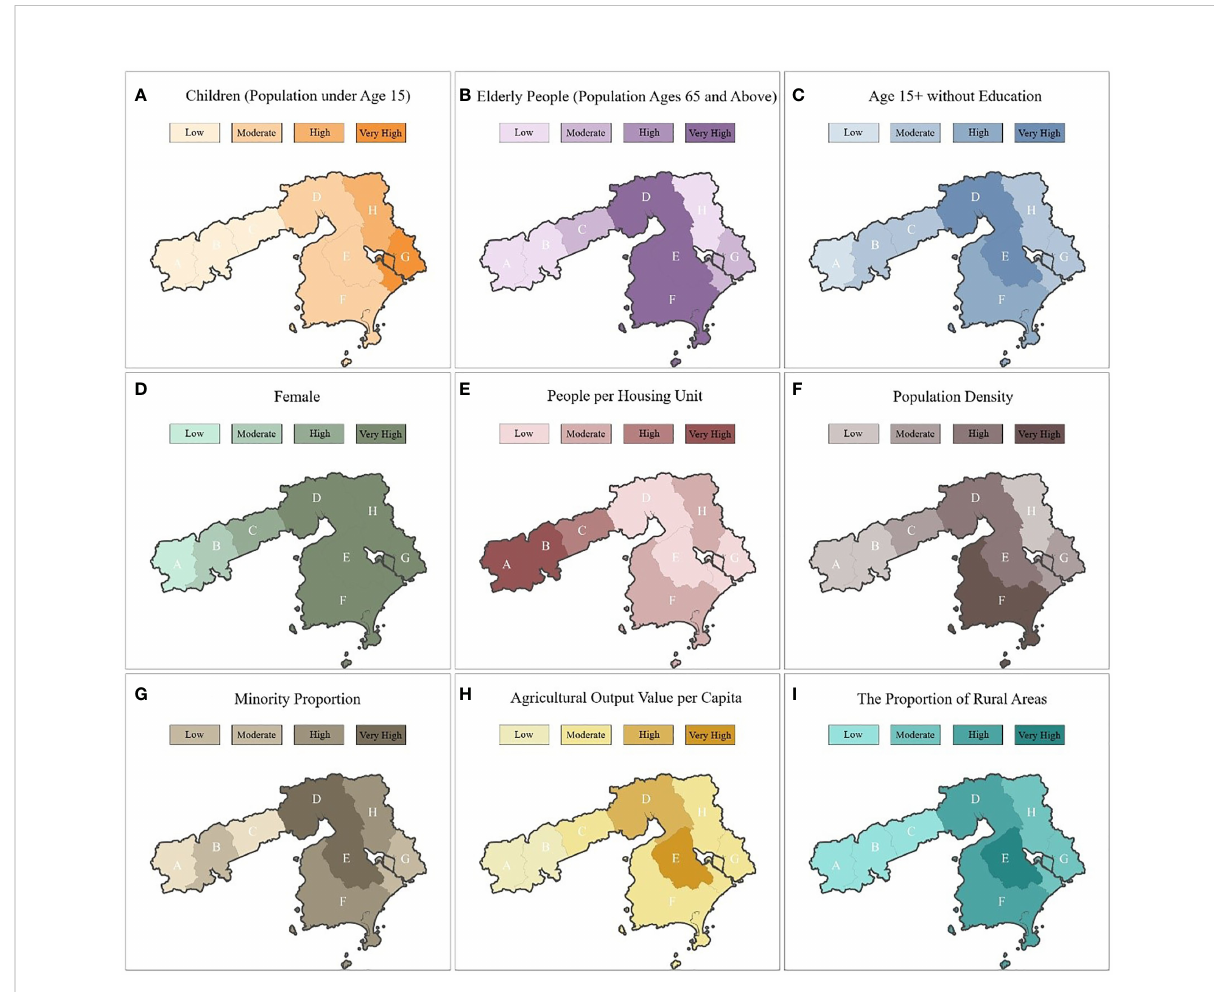
FIGURE 10 Mapping of spatial distribution of individual indictor and level of social vulnerability in the study area [ (A) Children (Population under age 15,); (B) Elderly people (Population ages 65 and above); (C) Age 15+ without education; (D) Female; (E) People per housing unit; (F) Population density; (G) Minority proportion; (H) Agricultural output value per capita; (I) The proportion of rural